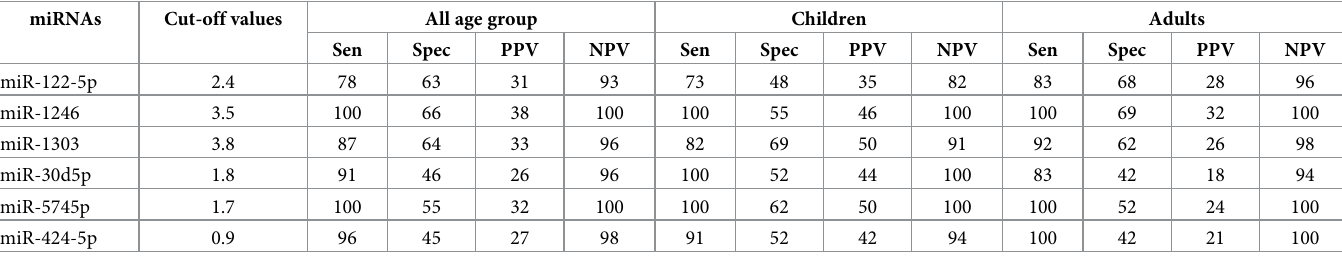
Table 3. Performance of serum miRNAs in the prediction of severe dengue. miRNAs Cut-off